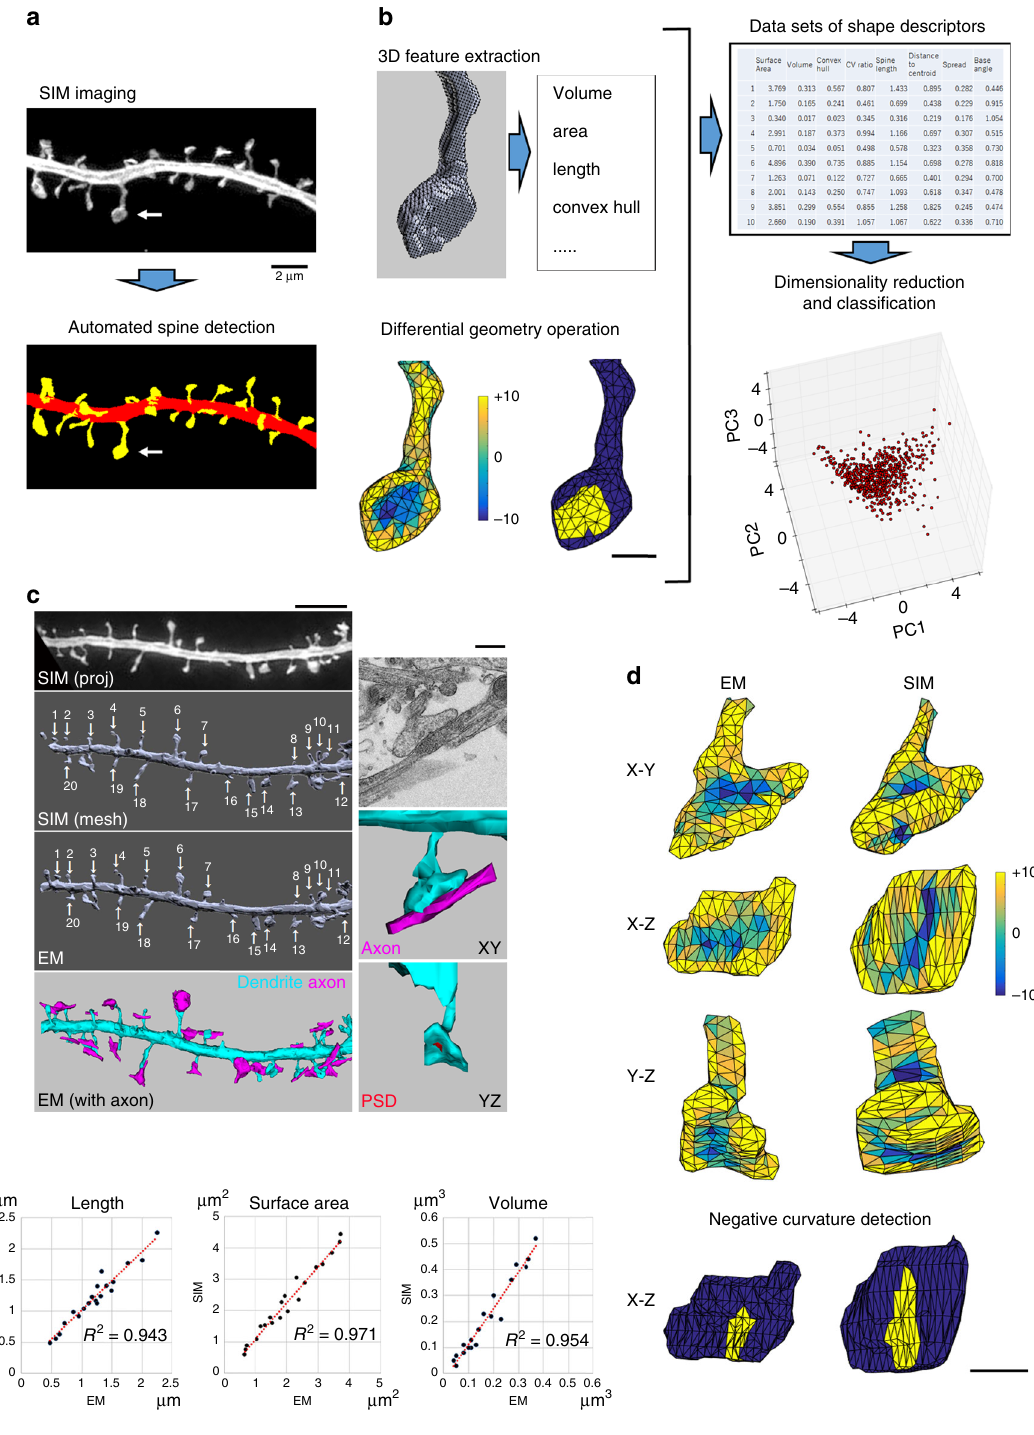
were preserved between the SIM-based and EM-based 3D data (Fig. 1d). The concave surface was present in 61% of spines of which volumes were more than 0.18 μ m 3 (this spine population corresponds to 25% of the total spines and 84% of them are classi fi ed as mushroom spines using our machine-learning method. See the next section for the detection of mushroom spines.) and matched the position of the synaptic junction and postsynaptic density (PSD) (Fig. 1c, d, Supplementary Figs. 6 and 7). Thus, the spine concave surface may be a biologically